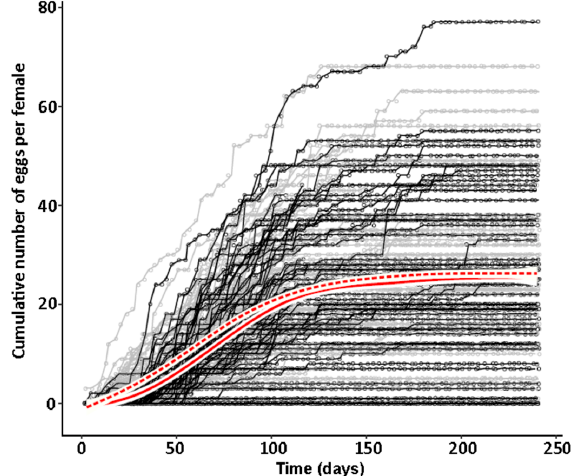
Figure 6. Time course of reproductive output (cumulative number of laid eggs) of single symbiotic (black circles and lines) versus aposymbiotic (grey circles and lines) O. surinamensis females from the JKI-2 experimental lines and average of both populations with 95% confidence intervals (symbiotic = continuous red line and white area, aposymbiotic = dashed red line and white area) reveal a window of approximately 90 days in which the reproductive output of symbiotic females lags behind that of aposymbiotic females by approximately 10 days.